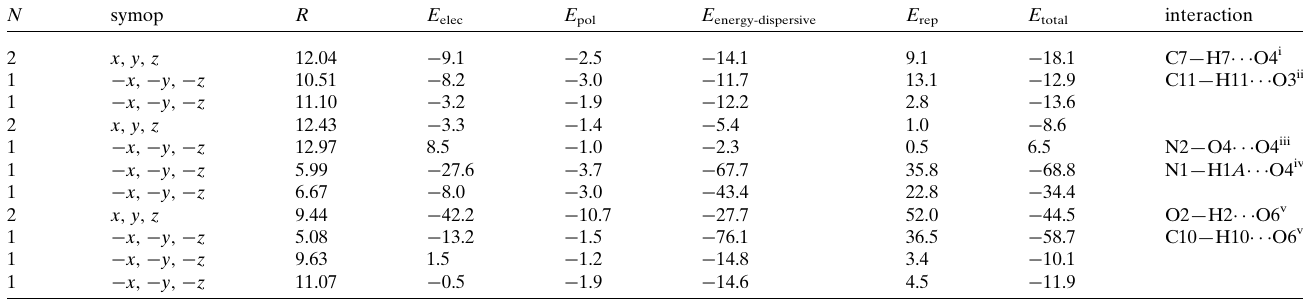
Table 3 Interaction energies for BF1-molA (kJ mol (cid:5) 1 ). R is the distance between molecular centroids (mean atomic position) in A˚ and N is the number of molecules at that distance. Total energies are the sum of the four energy components, scaled according to the appropriate scale factor ( a ) . N symop R E elec E pol